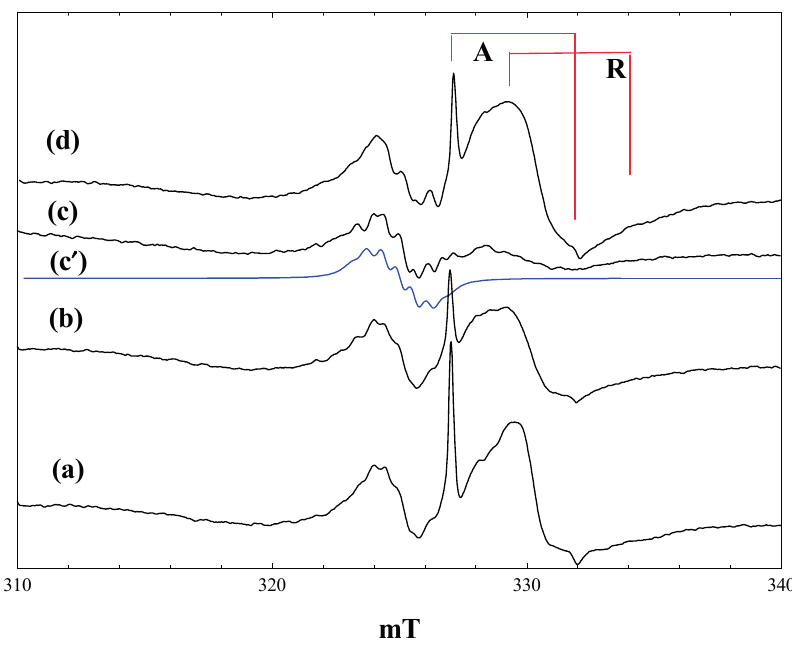
Figure 3. EPR spectra of P25 titania in a solution of phenoxyacetic acid in acetonitrile at 4 K. (a), During irradiation with low intensity 400 nm light; (b), During irradiation with high intensity 400 nm light; (c), during irradiation with high intensity broad band light; (d), after stopping irradiation; (c'), a simulated spectrum of the phenoxyacetic acid radical cation, as described in the